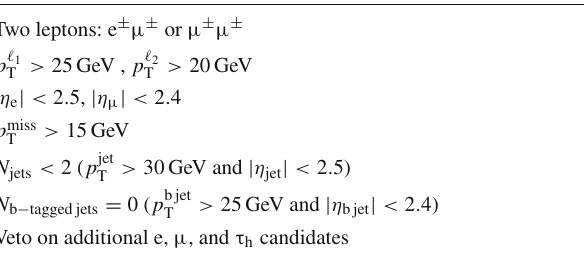
Table 1 Event selection criteria Two leptons: e ± μ ± or μ ± μ